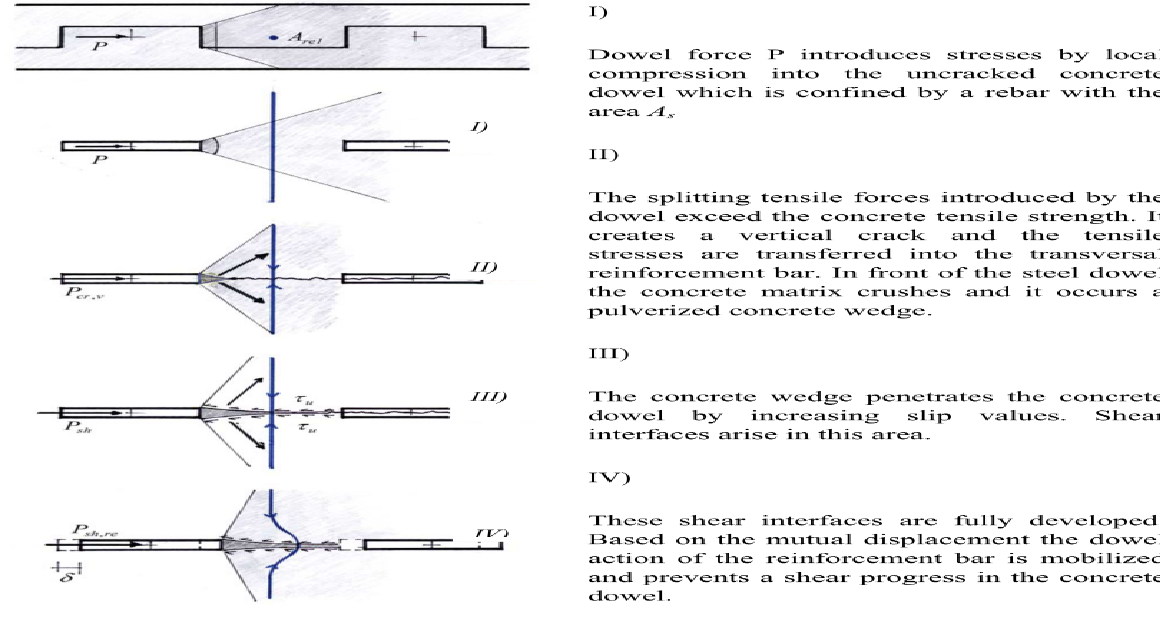
Figure 16: Shear failure mechanism of concrete dowel by Seidl [30] (last two stages of drawing from the final report [7]: III – the concrete wedge penetrates the concrete dowel and IV – the fully developed shear interfaces and mobilized the reinforcement